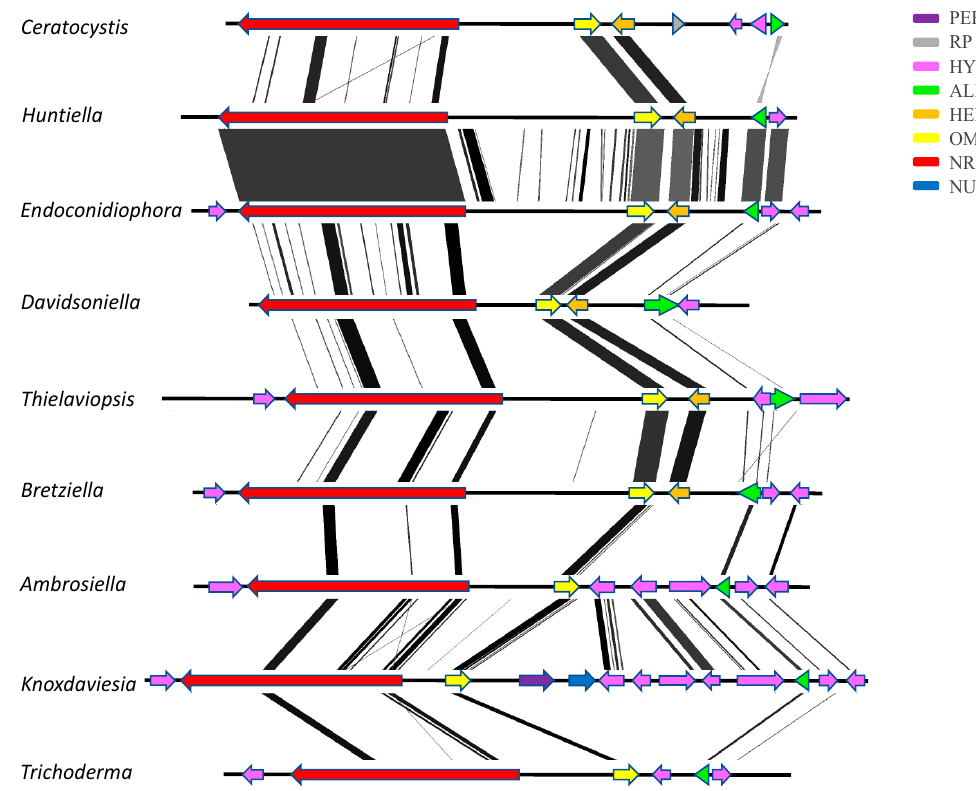
Figure 3. Comparison of the ferrichrome biosynthesis gene clusters of Ceratocystidaceae and Trichoderma virens . PER, peroxidase; RP, RNA polymerase transcription subunit; HYP, hypothetical protein; ALD, aldehyde dehydrogenase; HEP, endothiapepsin; OMO, orntithine monooxygenase; NRPS, nonribosomal peptide synthetase; NUC, nuclease. Shaded lines represent similarities between nucleotide sequences. The figure was generated using EASYFIG version 2.2.2 (http://mjsull.github.io/Easyfig/files.html) and the GenBank information for each cluster.